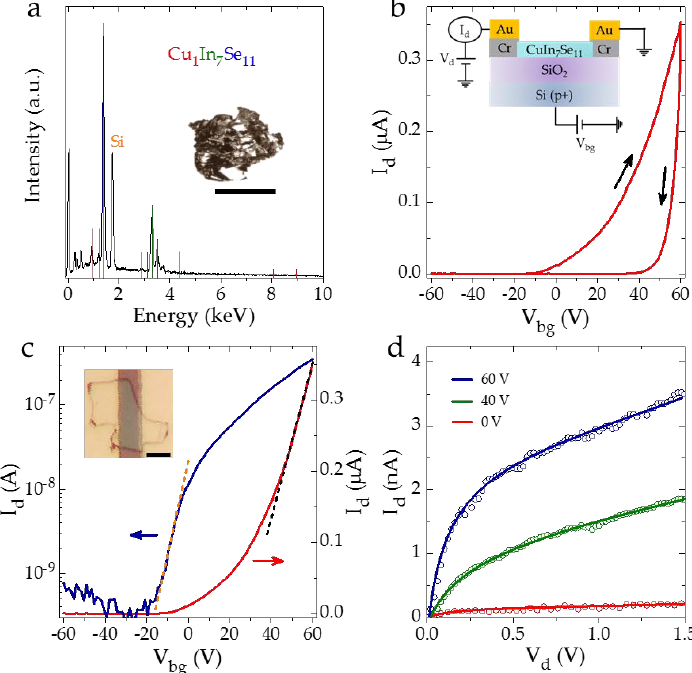
Figure 1. Structural characterization of CuIn 7 Se 11 and electronic transport of a CuIn 7 Se 11 FET with a dielectric gate (Device I): ( a ) Energy-dispersive X-ray spectrum of CuIn 7 Se 11 flake indicating Cu:In:Se in a 1:7:11 ratio where red, green and blue lines correspond to copper, indium and selenium, respectively; Inset: optical image of bulk crystal with scale bar as 1 mm; ( b ) Transfer characteristics with a dielectric gate for forward cycle and reverse cycle; Inset: schematic of FET; ( c ) Transfer characteristics with a dielectric gate for forward cycle in the linear scale (red) and semi-log scale (blue); Inset: optical image of typical device (Device II) with scale bar as 10 μm; and ( d ) output characteristics under different back gate voltages (0 V ≤ V bg ≤ +60 V) are shown.